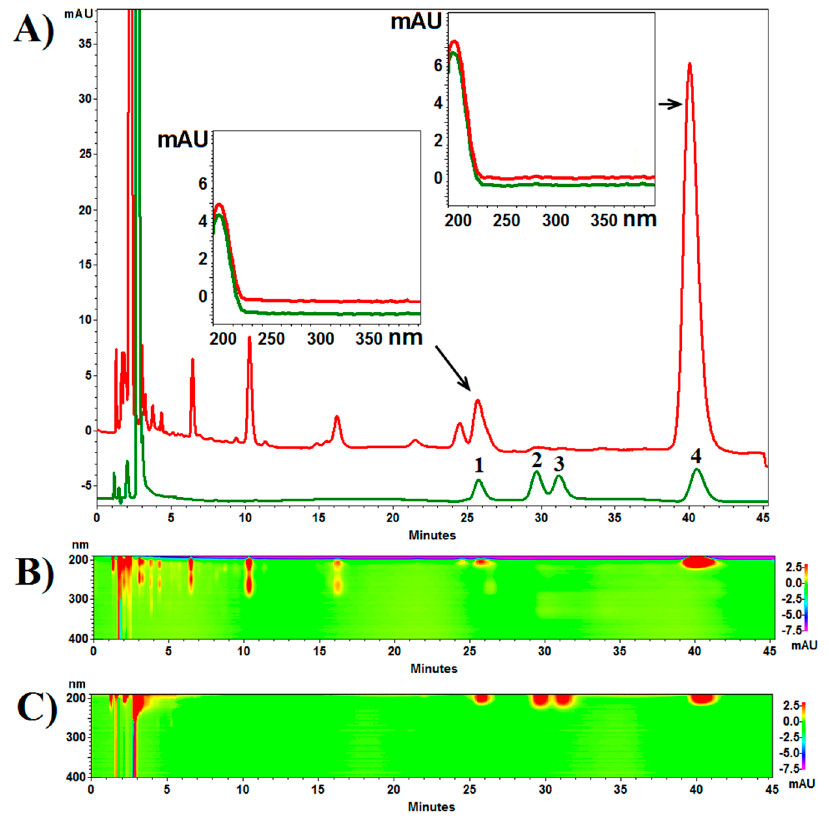
Figure 4. ( A ) Example chromatograms of birch bark extract (red line) and reference compounds (green line): 1 (betulinic acid), 2 (oleanolic acid), 3 (ursolic acid), 4 (betulin). Over the chromatograms the spectra of identified and reference compounds. ( B , C ); The spectro-chromatograms of extract and reference compounds, respectively. RP18e LiChro-spher, acetonitrile–water—phosphoric acid aqueous solution at concentration of 1% (75:25:0.5, v / v / v ), flow rate 1.0 mL/min at 10 °C.